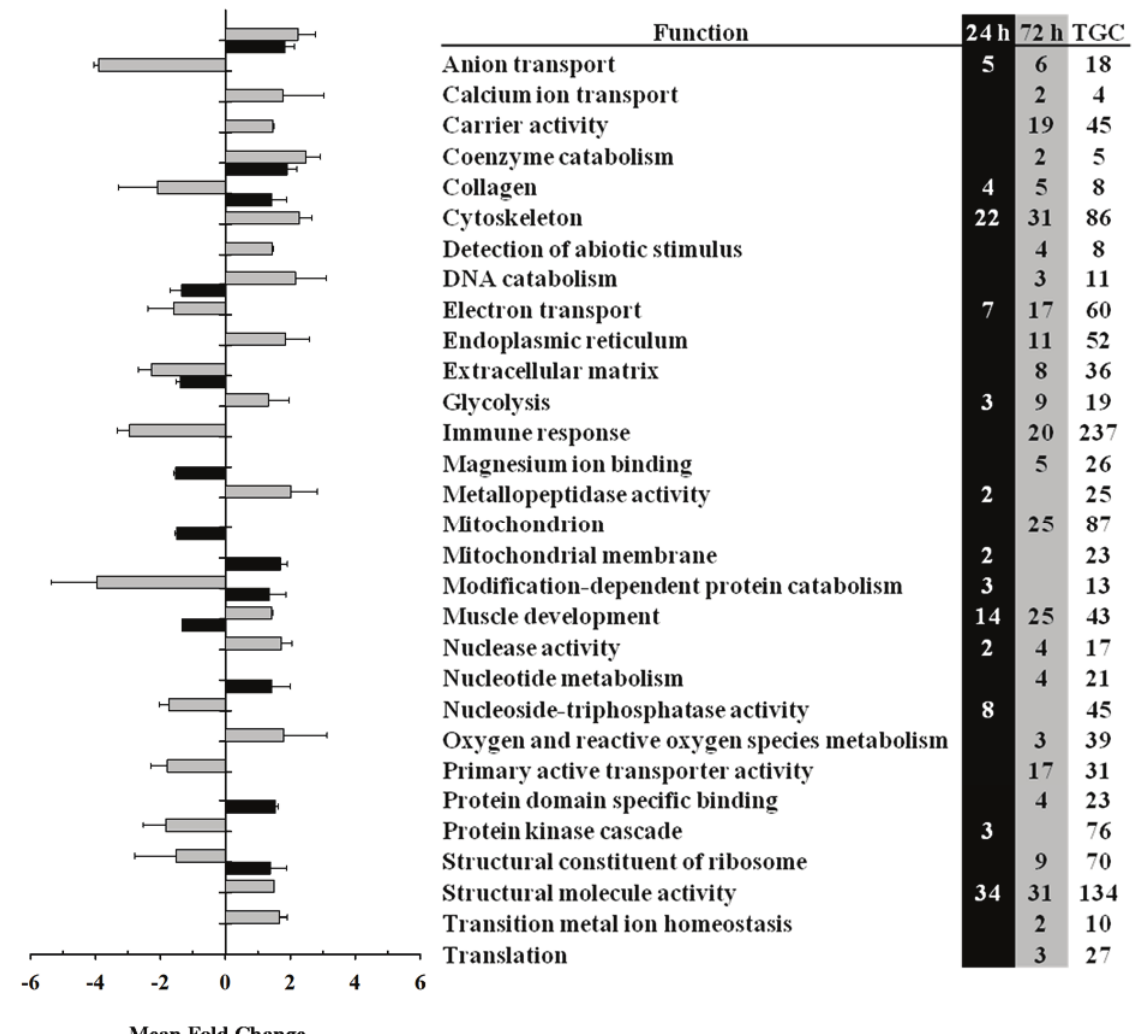
Figure 2. Gene Ontology analysis for slow skeletal muscle at 24 h (black bars) and 72 h (grey bars) after lipopolysaccharide (LPS) administration in trout. Differentially expressed genes (DEGs) were grouped by gene ontology functional categories and fold change differences were analyzed by Student’s t -test ( p < 0.05). TGC indicates the total number of genes included in each functional category. Data are shown as mean fold